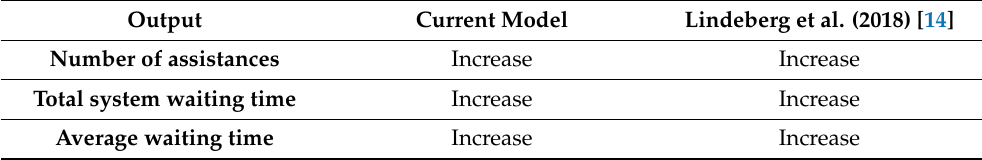
Table 4. Validation by comparison with other models for increase in vessel speed